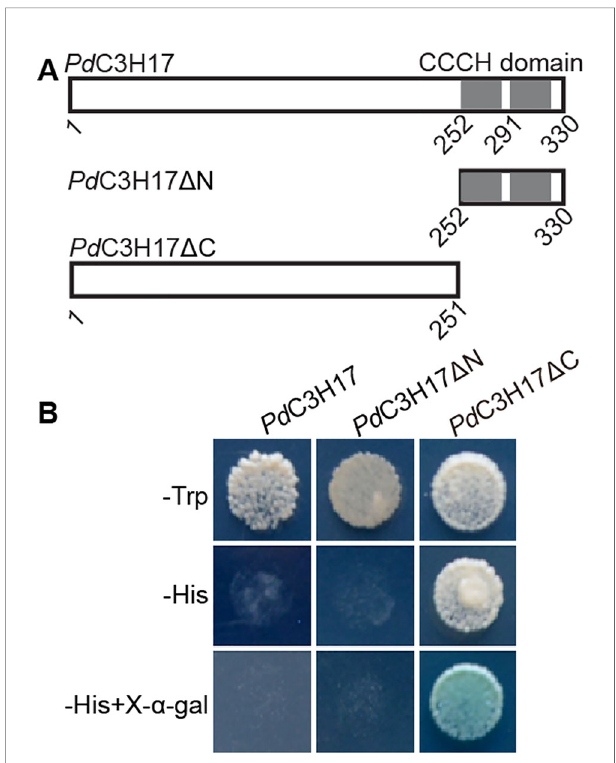
FIGURE 1 | Transactivation analysis of different regions of Pd C3H17 fused with the GAL4 DNA-binding domain in yeast. (A) Diagram of Pd C3H17, Pd C3H17 D N, and Pd C3H17 D C proteins. (B) Only Pd C3H17 D C is able to activate the expression of the HIS3 reporter